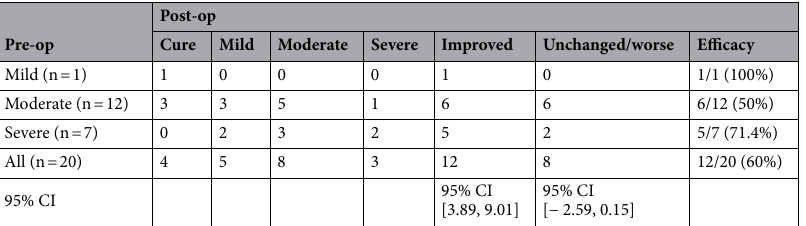
Figure 1. Changes in grades of stress urinary incontinence following treatment of PRP injection.